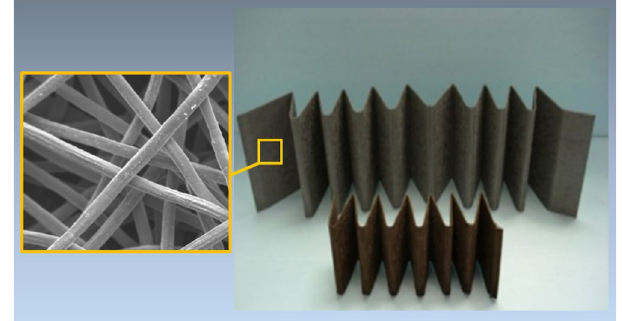
Figure 1. Pleated sintered-metal-fibers made of FeCrAl.